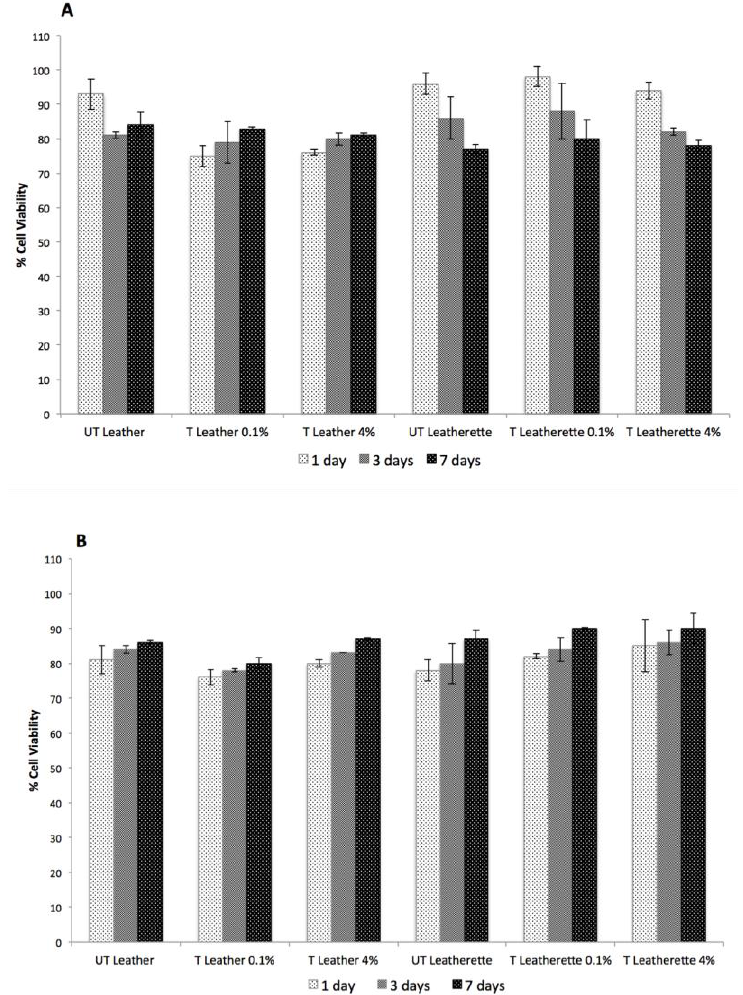
Figure 10. MTT assays at 1, 3 and 7 days before ( A ) and after ( B ) the abrasion test. UT = untreated, T = treated; 0.1% and 4% represent the weight percentages adopted for the treatment of the samples.